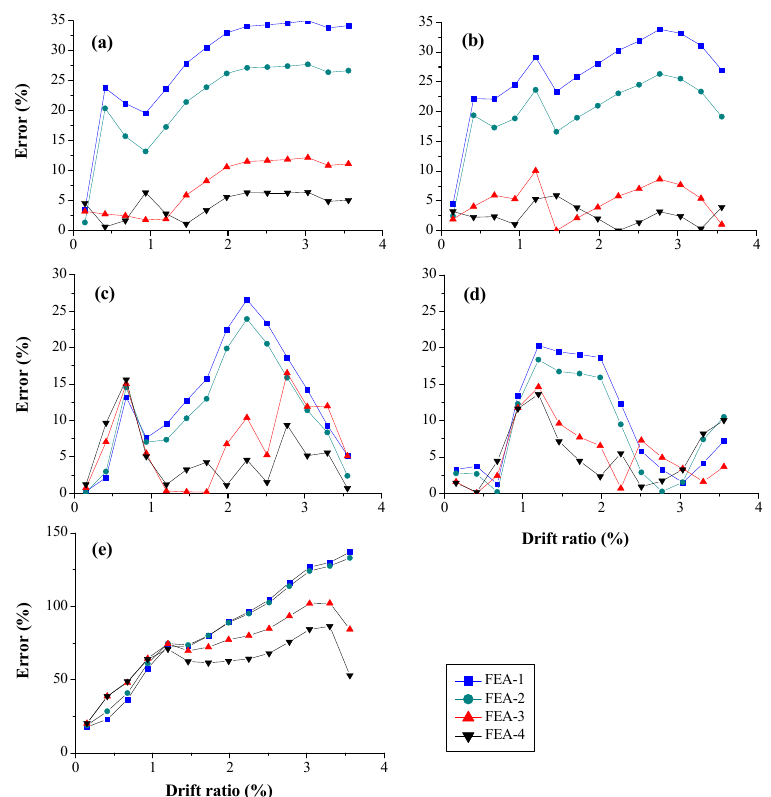
Figure 13. Root-mean-square error of concrete stress at the location of: ( a ) Point I; ( b ) Point V; ( c ) Point II, ( d ) Point IV; and ( e ) Point III.